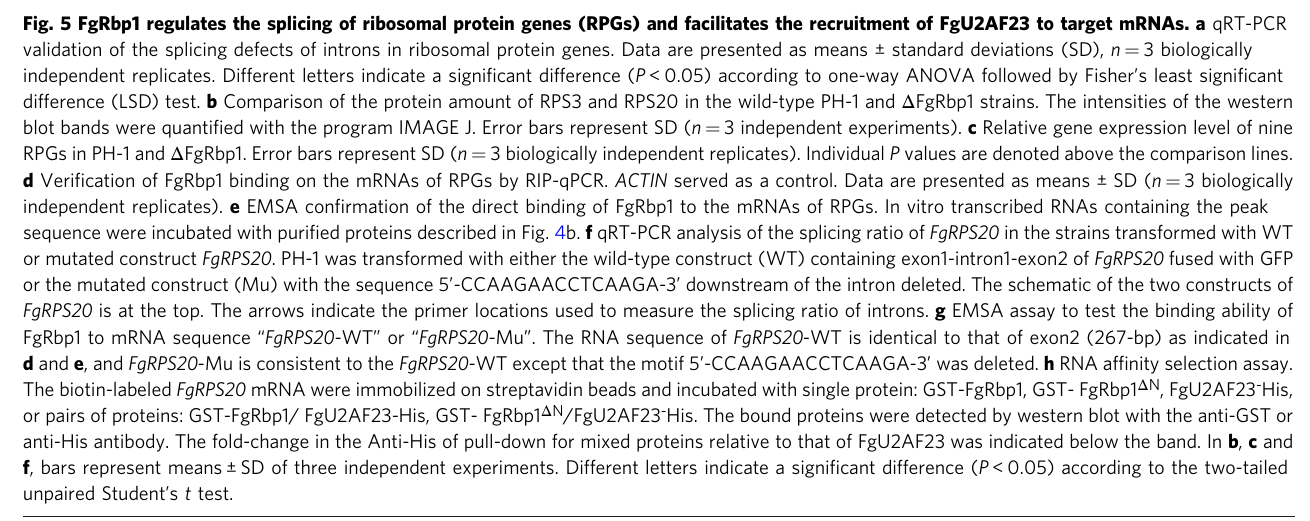
Fig. 5 FgRbp1 regulates the splicing of ribosomal protein genes (RPGs) and facilitates the recruitment of FgU2AF23 to target mRNAs. a qRT-PCR validation of the splicing defects of introns in ribosomal protein genes. Data are presented as means ± standard deviations (SD), n = 3 biologically independent replicates. Different letters indicate a signi fi cant difference ( P < 0.05) according to one-way ANOVA followed by Fisher ’ s least signi fi cant difference (LSD) test. b Comparison of the protein amount of RPS3 and RPS20 in the wild-type PH-1 and Δ FgRbp1 strains. The intensities of the western blot bands were quanti fi ed with the program IMAGE J. Error bars represent SD ( n = 3 independent experiments). c Relative gene expression level of nine RPGs in PH-1 and Δ FgRbp1. Error bars represent SD ( n = 3 biologically independent replicates). Individual P values are denoted above the comparison lines. d Veri fi cation of FgRbp1 binding on the mRNAs of RPGs by RIP-qPCR. ACTIN served as a control. Data are presented as means ± SD ( n = 3 biologically independent replicates). e EMSA con fi rmation of the direct binding of FgRbp1 to the mRNAs of RPGs. In vitro transcribed RNAs containing the peak sequence were incubated with puri fi ed proteins described in Fig. 4b. f qRT-PCR analysis of the splicing ratio of FgRPS20 in the strains transformed with WT or mutated construct FgRPS20 . PH-1 was transformed with either the wild-type construct (WT) containing exon1-intron1-exon2 of FgRPS20 fused with GFP or the mutated construct (Mu) with the sequence 5 ’ -CCAAGAACCTCAAGA-3 ’ downstream of the intron deleted. The schematic of the two constructs of FgRPS20 is at the top. The arrows indicate the primer locations used to measure the splicing ratio of introns. g EMSA assay to test the binding ability of FgRbp1 to mRNA sequence “ FgRPS20 -WT ” or “ FgRPS20 -Mu ” . The RNA sequence of FgRPS20 -WT is identical to that of exon2 (267-bp) as indicated in d and e , and FgRPS20 -Mu is consistent to the FgRPS20 -WT except that the motif 5 ’ -CCAAGAACCTCAAGA-3 ’ was deleted. h RNA af fi nity selection assay. The biotin-labeled FgRPS20 mRNA were immobilized on streptavidin beads and incubated with single protein: GST-FgRbp1, GST- FgRbp1 Δ N , FgU2AF23 - His, or pairs of proteins: GST-FgRbp1/ FgU2AF23-His, GST- FgRbp1 Δ N /FgU2AF23 - His. The bound proteins were detected by western blot with the anti-GST or anti-His antibody. The fold-change in the Anti-His of pull-down for mixed proteins relative to that of FgU2AF23 was indicated below the band. In b , c and f , bars represent means ± SD of three independent experiments. Different letters indicate a signi fi cant difference ( P < 0.05) according to the two-tailed unpaired Student ’ s t